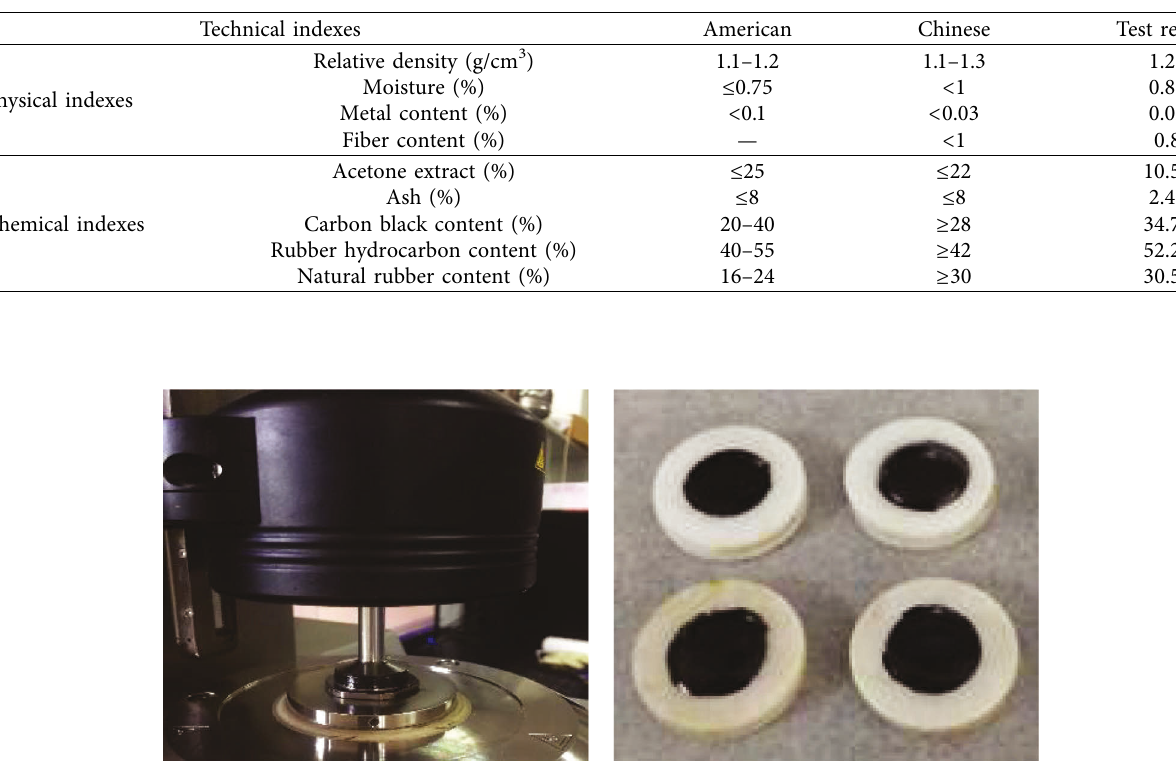
Figure 1: Raw materials: (a) crumb rubber and (b) waste oil. Table 2: Technical index of crumb rubber.